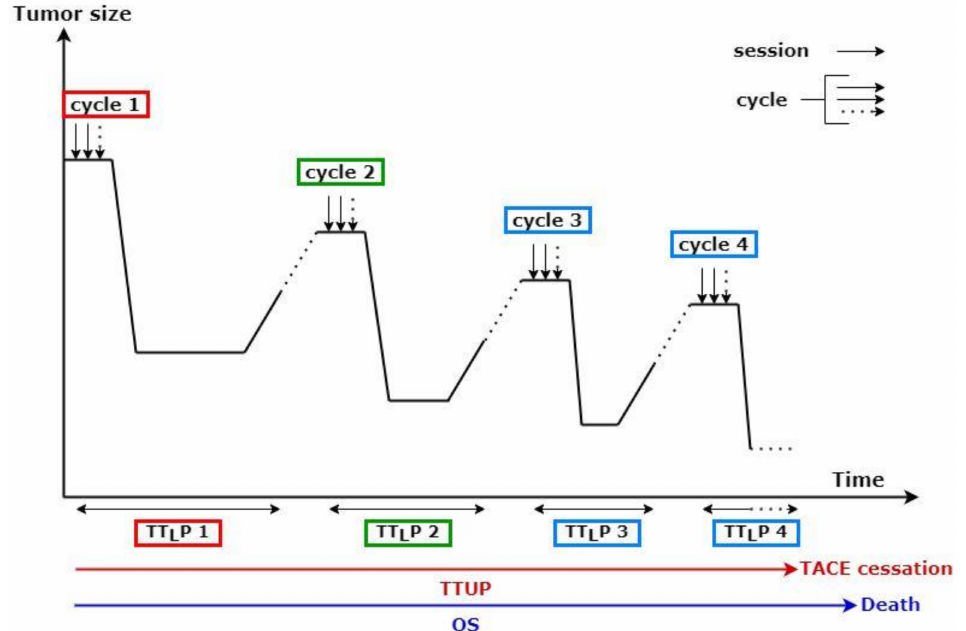
Figure 1. Schematic representation of transarterial chemoembolization (TACE) delivery protocol. TT L P: time to liver progression; TTUP: time untreatable progression; OS: overall survival; TT L P 1 corresponded to the first cycle, TT L P 2 to the second, and so